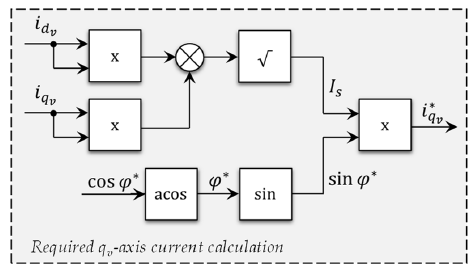
Figure 18. Required q v ‐ axis calculation block.